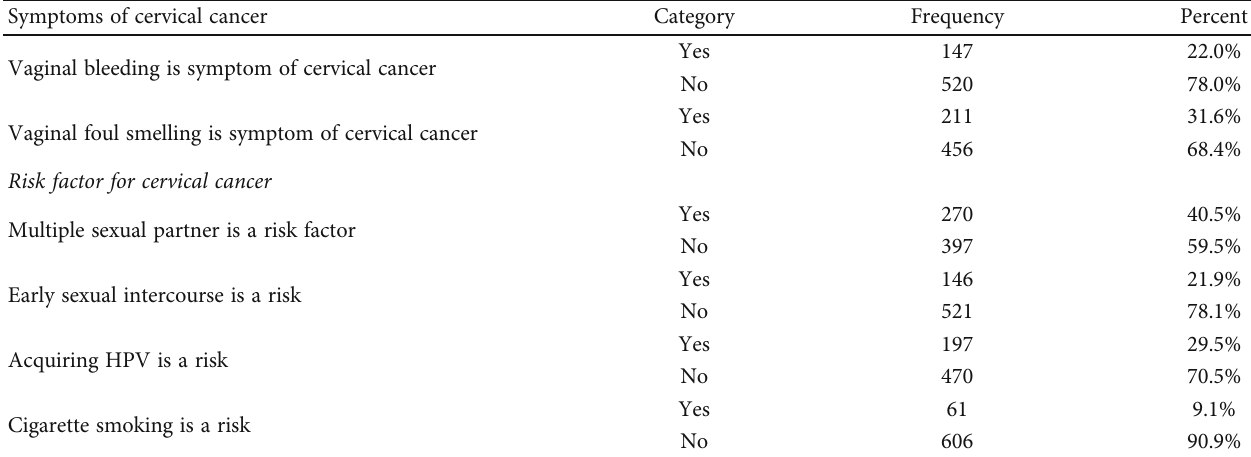
Table 3: Respondents ’ knowledge about symptoms and risk factors of cervical cancer at Adama Science and Technology University students, Adama, Ethiopia, May